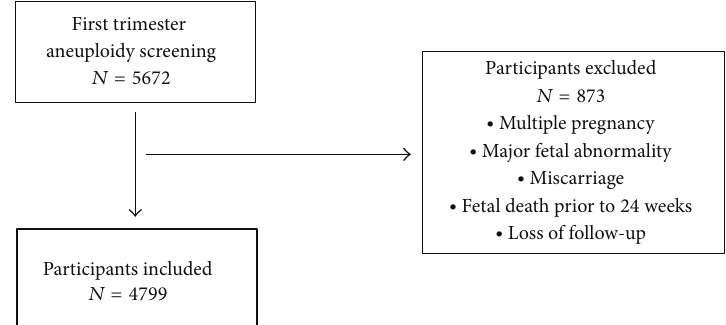
Figure 1: Flow chart of the study